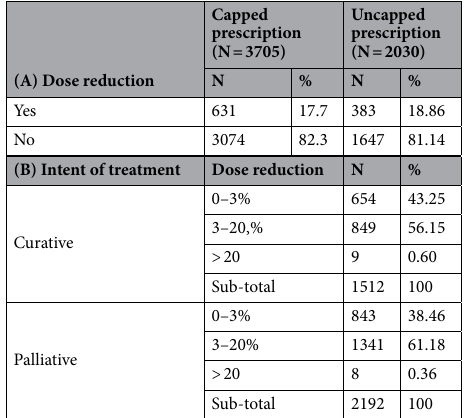
Table 6. (A) Dose reduction in prescriptions with BSA > 2 m 2 , (B) Dose reduction induced by BSA capping according to the intent of